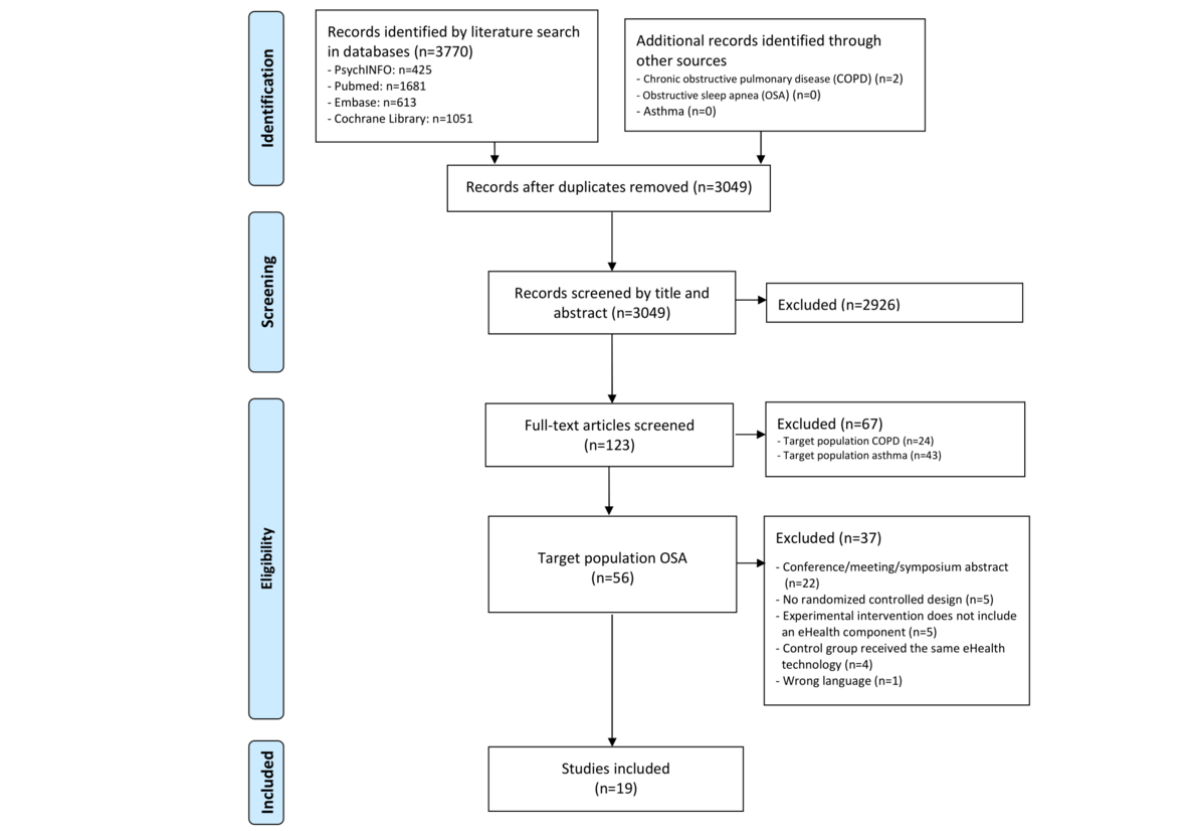
Figure 1. PRISMA flowchart describing the study identification and selection